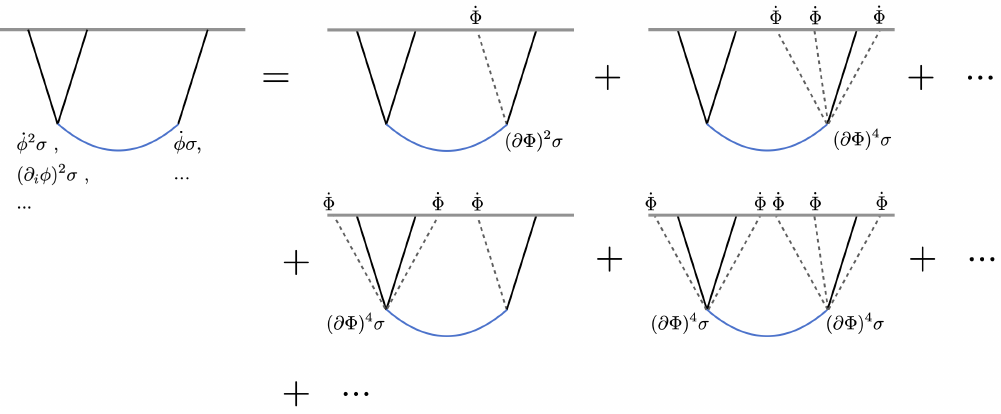
Figure 2 . A diagrammatic illustration of how large boost-breaking interactions arise for the exchange bispectrum. In Feynman diagrams of cosmological correlators, the breaking of the boost symmetry is normally associated with evaluating external legs of the massless scalar to the background (the dashed lines with ˙Φ ). The (boostless) EFT diagram on the left encompasses all the higher-derivative contributions on the right-hand side